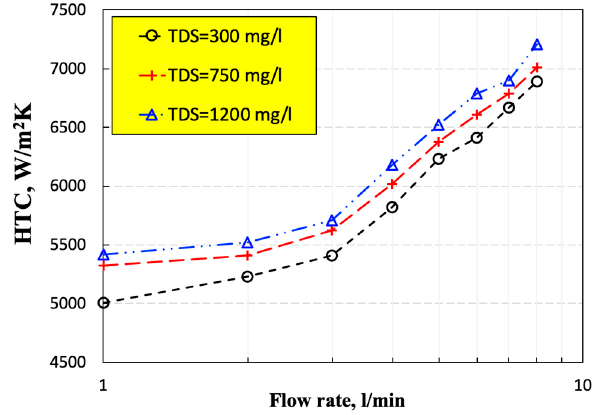
Figure 10. Curves of heat transfer coefficient (HTC) vs. flow rate ( Q) for different TDS values at thermal flux equal to 75 kW/m 2 .